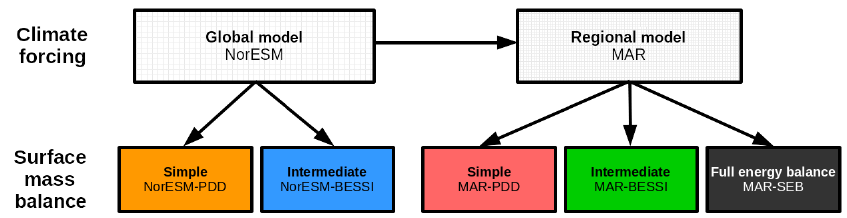
Figure 3. Overview of the experimental design. The simple PDD and intermediate BESSI SMB simulations are forced with output of our global climate (from NorESM) and the regional climate (from MAR). Additionally SMB is derived from the SEB model implemented in MAR. This flow of experiments is performed in the same way for all five time slices (130, 125, 120, 115ka, and pre-industrial).